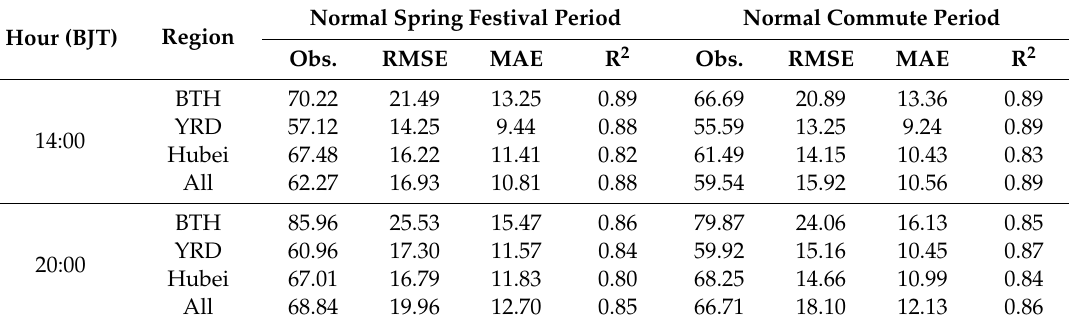
Table 4. Average di ff erence of the PM 2.5 concentration under di ff erent emission scenarios. PM sd − ˆ PM sd | nsf Area